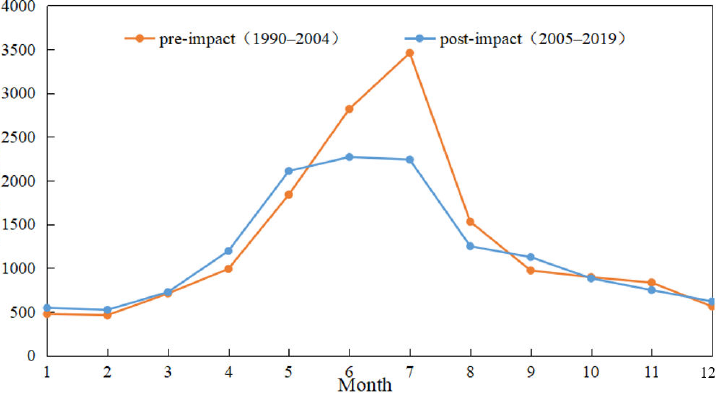
Figure 4. Comparison of monthly median flow of Wulong Station in the different periods.